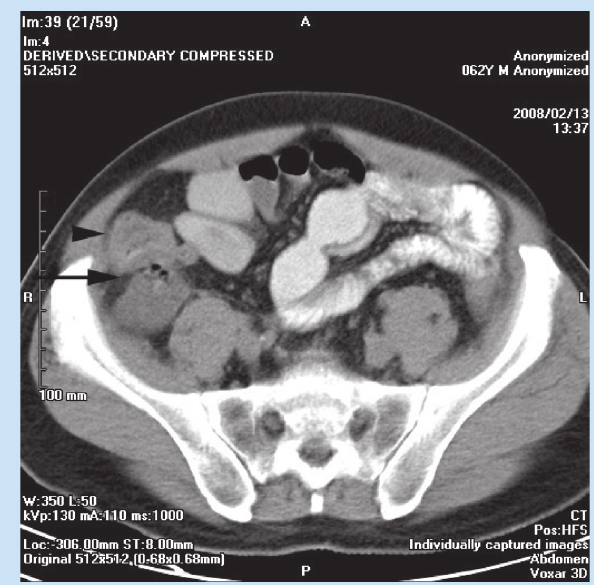
Fig. 1. CT scan of the abdomen. Gas and fluid-containing collection (arrow) present posterior to the caecum (arrowhead). The appendix itself is not visualised separate to the collection. Adjacent mesenteric stranding is evident.